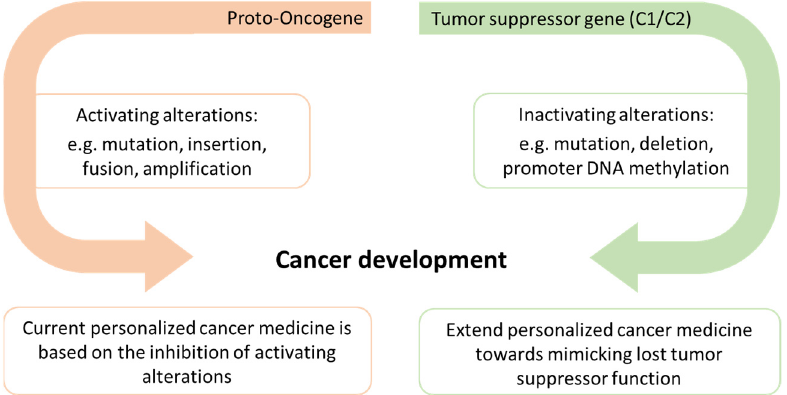
Figure 1. Alterations in both proto-oncogenes and tumor suppressor genes may lead to cancer development, but current personalized cancer medicine is mainly based on the inhibition of activating alterations. We propose to expand the scope of personalized cancer medicine by developing tumor suppressor protein-specific mimetic drugs that can partially or fully substitute the lost tumor suppressive function.